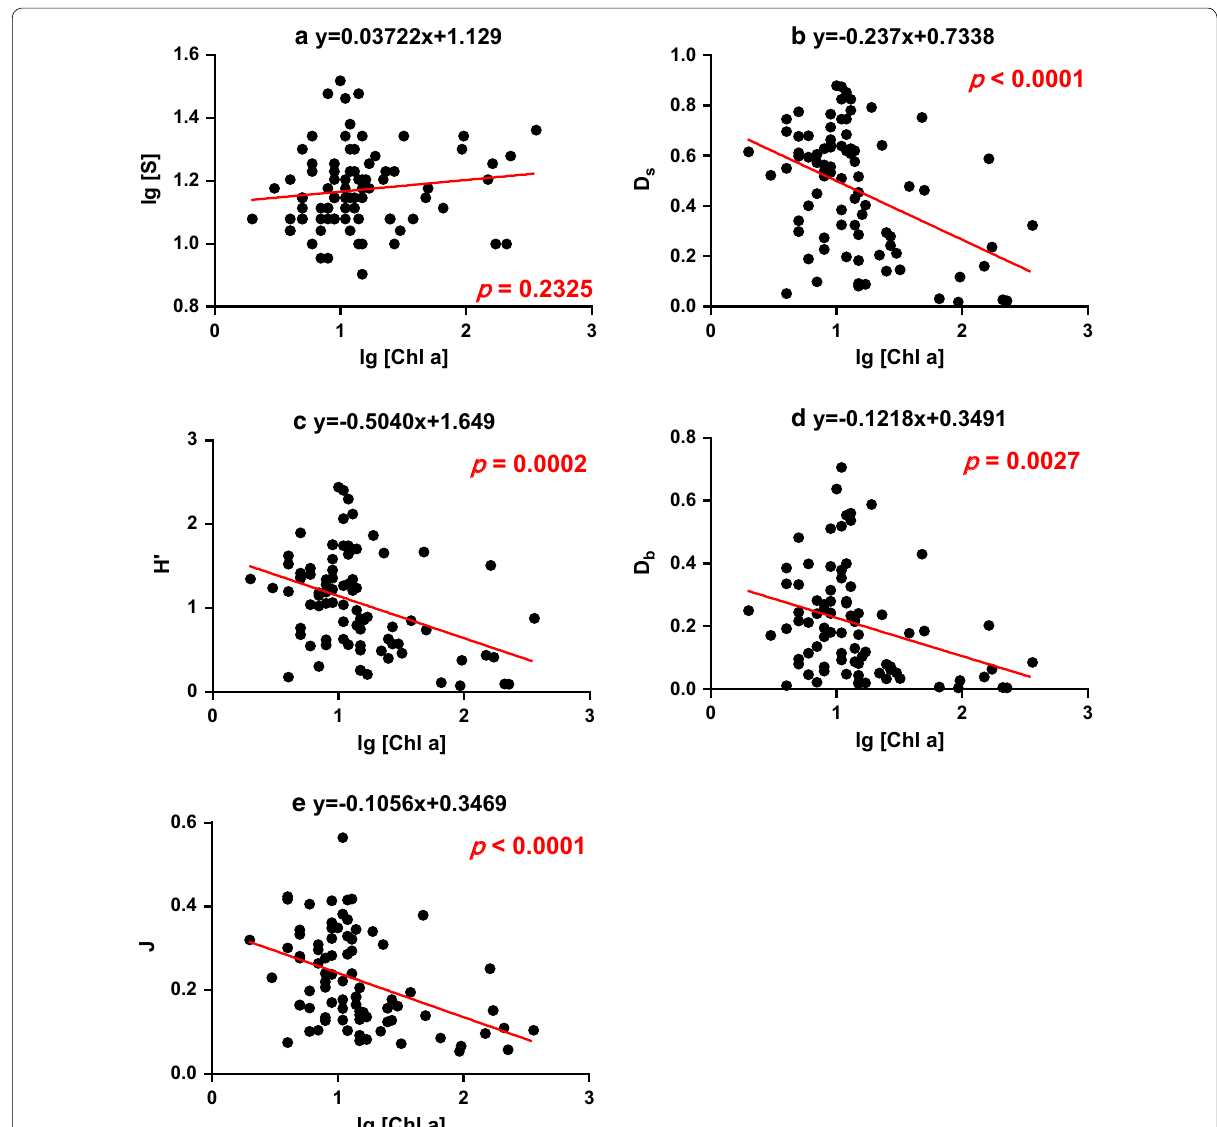
Fig. 3 Scatter plots and linear regressions between productivity of phytoplankton (expressed in Chl a ; log transformed) and measures of diversity of the phytoplankton community ( S (log transformed), D s , H ′ , D b and J ) in Tai Lake. The curves were fitted based on n and p value for the specific linear regressions are given in each